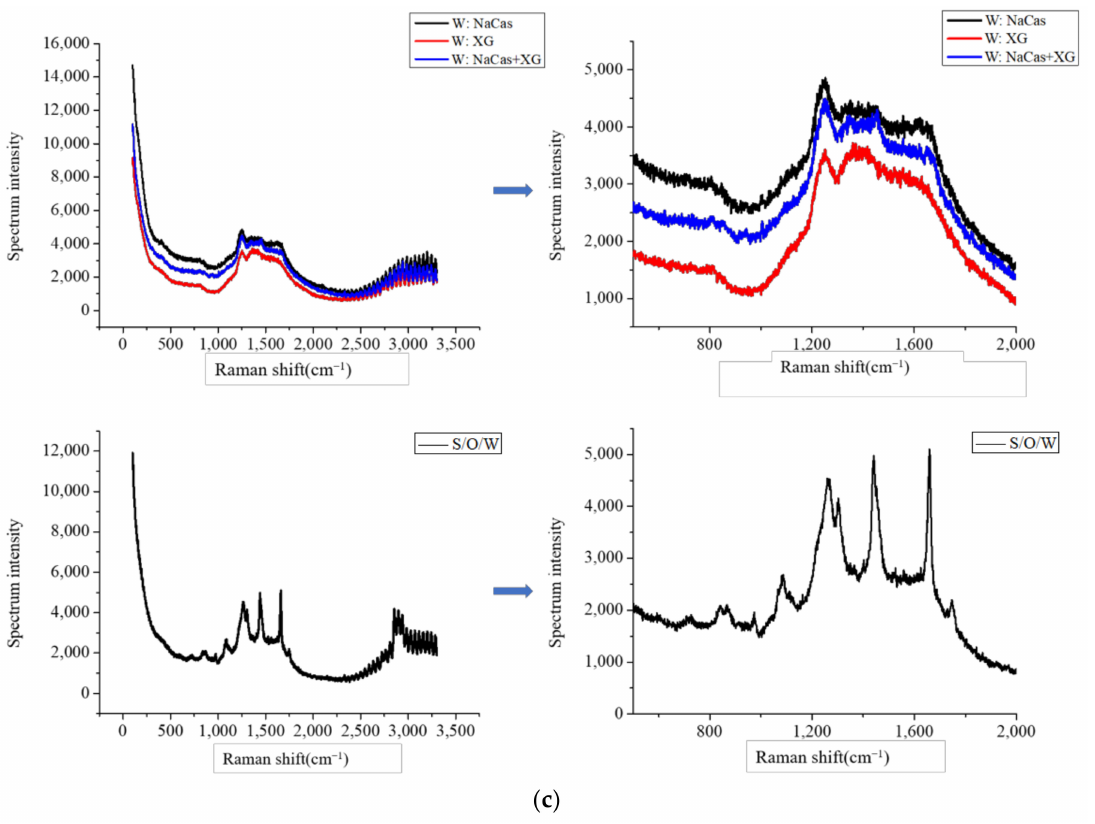
Figure 5. The XRD ( a ), Infrared spectral ( b ), and Raman spectrum analysis ( c ) of the CaCO 3 S/O/W